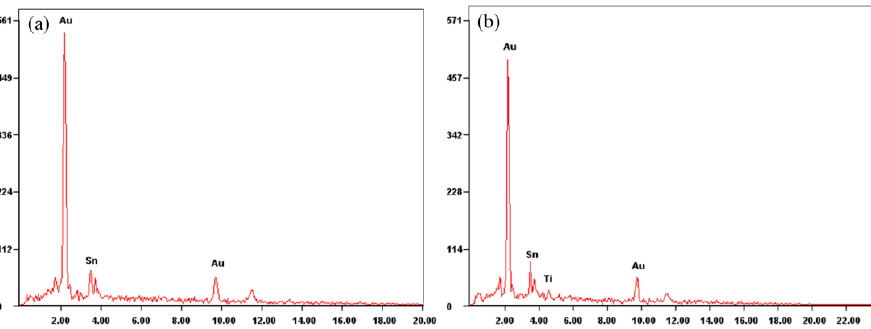
Figure 12. The MMIC sample in Figure 11a separated by “hot-lifting.”